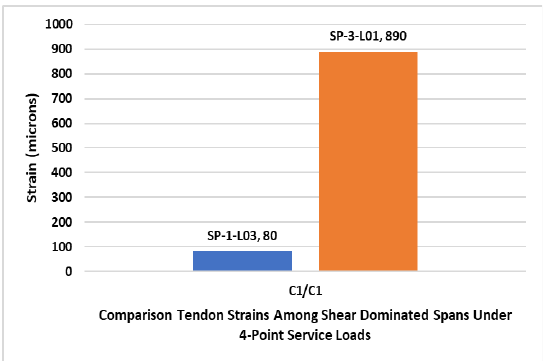
Figure 46. Comparison of maximum tendon strains recorded under four-point service loads between specimen SP-1 and SP-3.